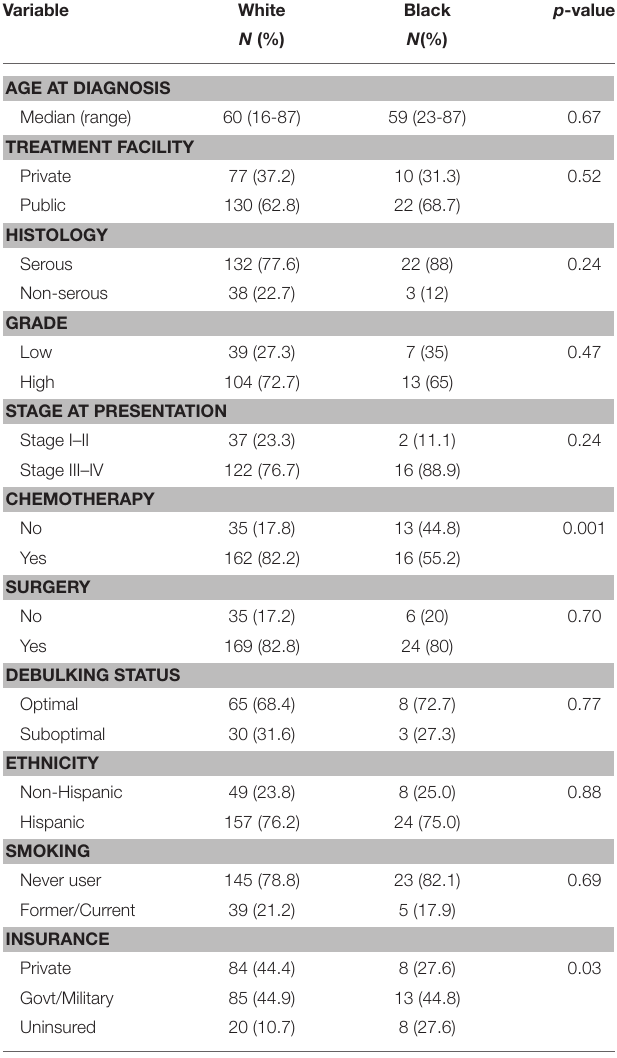
TABLE 3 | Demographics of Caribbean-born patients, by race. Variable White